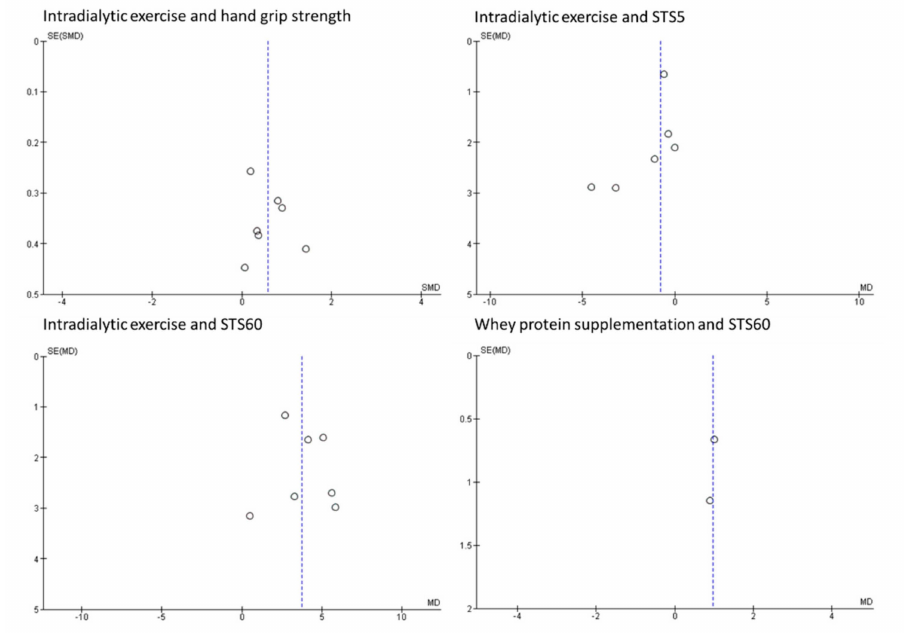
Figure A4. Funnel plots for primary outcomes. SE = standard error, MD = mean